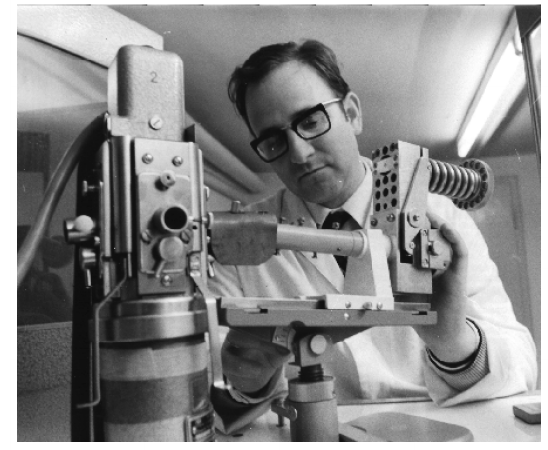
Figure 23. Waesch at the